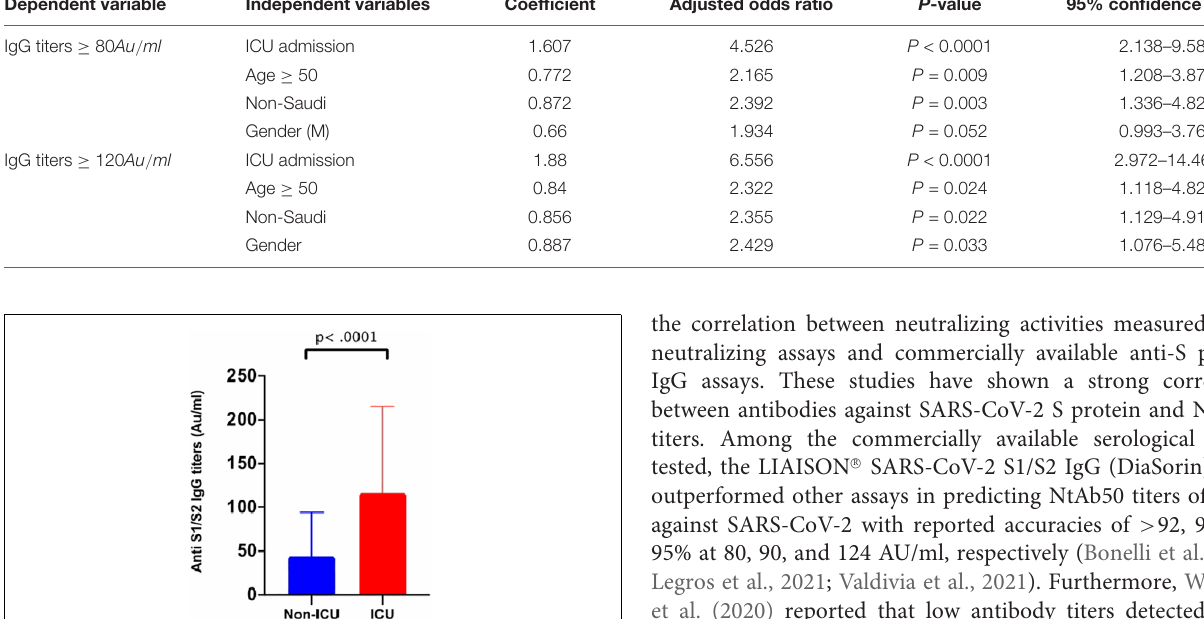
FIGURE 2 | Distribution of Anti S1/S2 IgG titers stratified by symptoms. Grouped scatterplot showing no significant difference in anti S1/S2 IgG titers between symptomatic and asymptomatic participants with COVID-19 ( p = ns). TABLE 3 | Multivariant logistic regression analysis for predictors of high IgG antibody titers after SARS-CoV-2 infection. Dependent variable Independent variables Coefficient